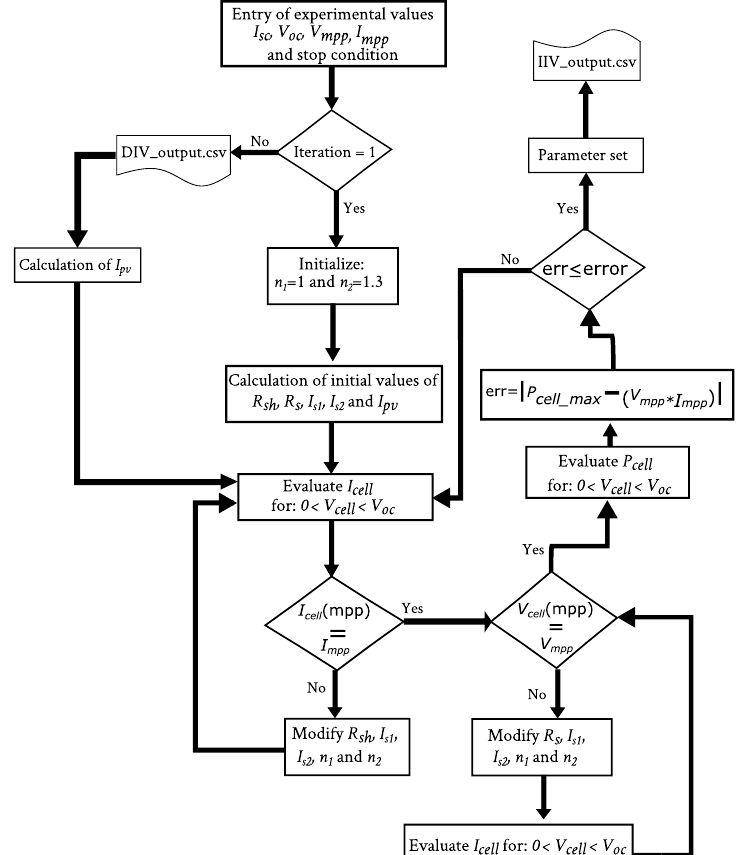
Figure 3. Flow diagram of the IIVf